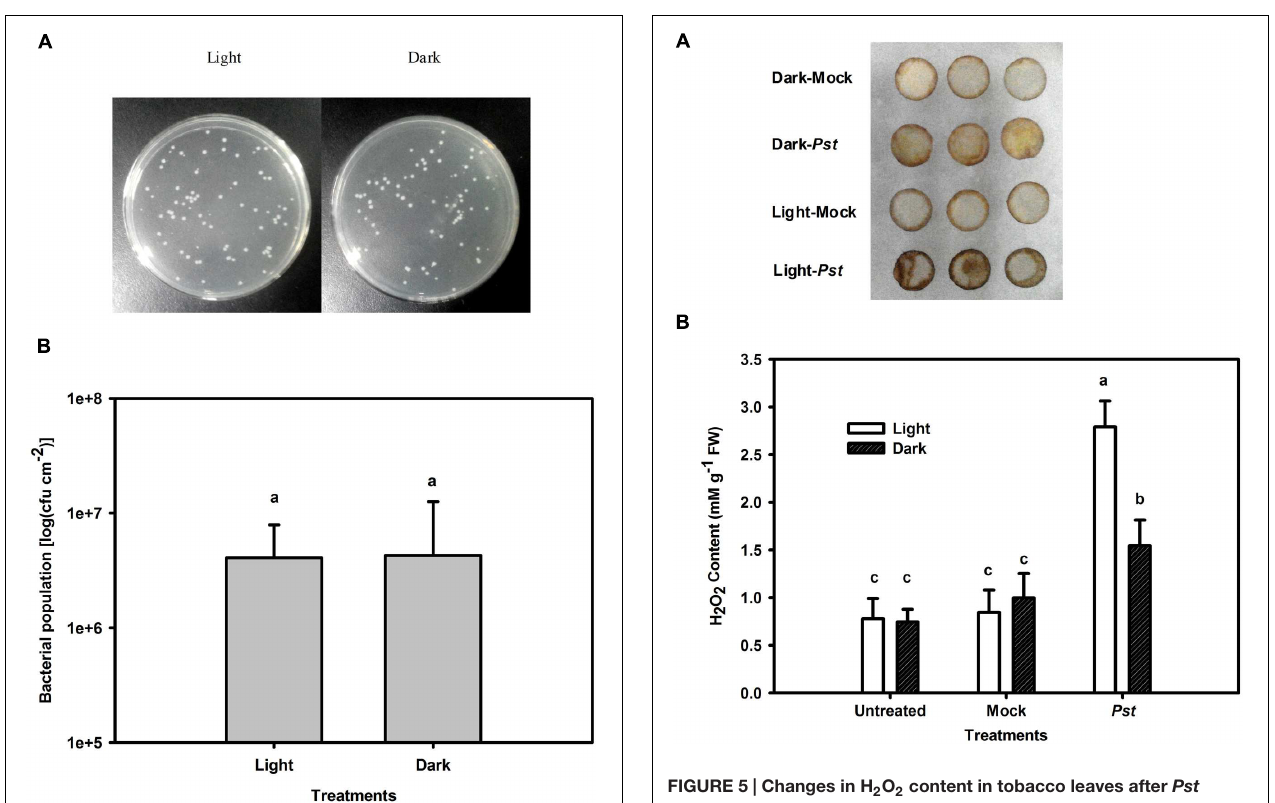
FIGURE 5 | Changes in H 2 O 2 content in tobacco leaves after Pst infection. (A) Histochemical detection of H 2 O 2 accumulation using DAB staining in tobacco leaves after infiltration with distilled water (mock) or Pst under light (200 µ mol m − 2 s − 1 ) or dark conditions. (B) The H 2 O 2 content in tobacco leaves at 3 dpi of Pst under light or dark conditions. Means ± SE of six replicates are presented. Different letters above the columns indicate significant differences between treatments at P <